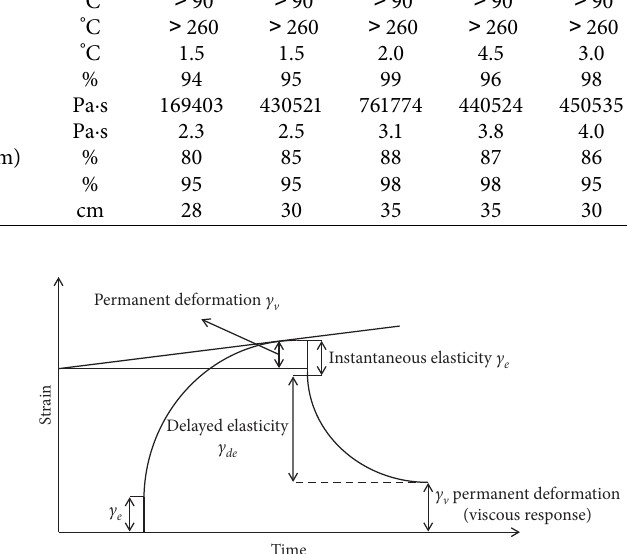
Figure 1: Creep-recovery response of binders.